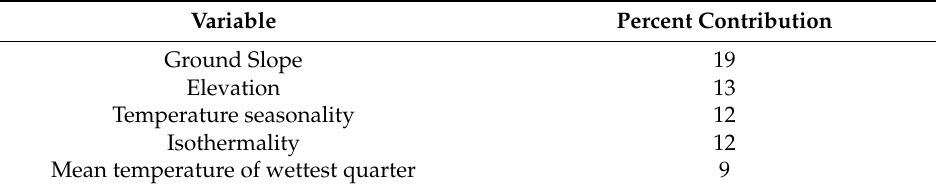
Table A5. Variable contribution for Random Forest